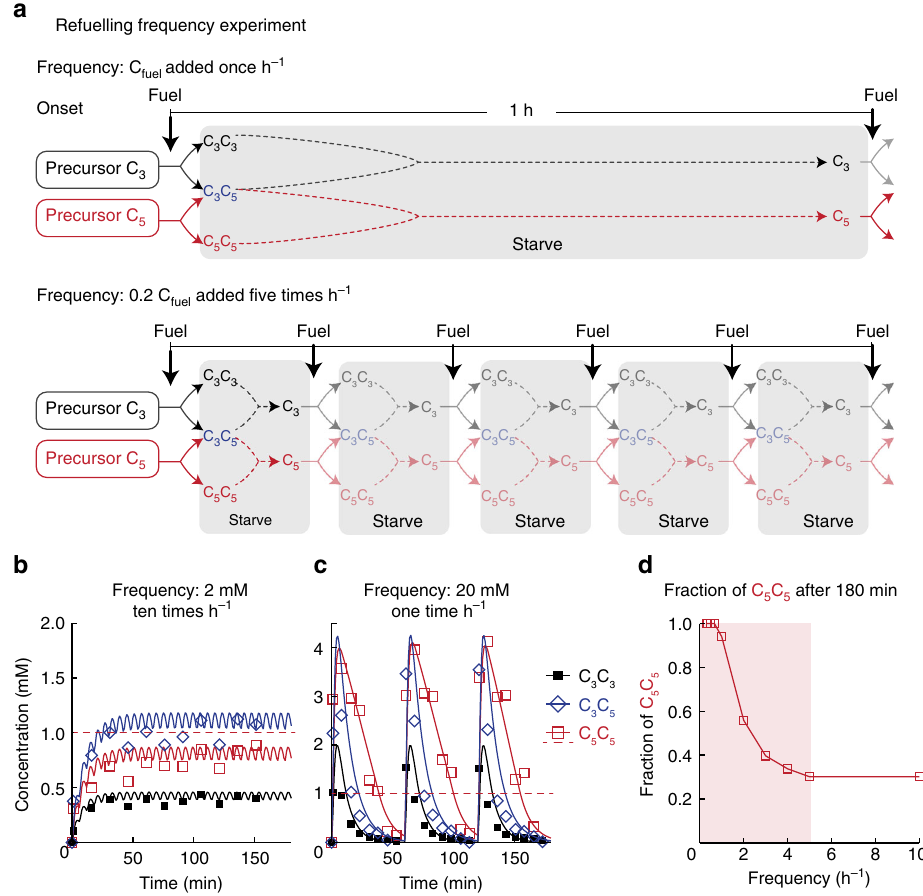
Fig. 3 The method of fueling affects the selection process. a Minimalistic representation of the chemical reaction networks in competition experiments with varying frequency of fueling. Solutions of 300 mM C 3 and 300 mM C 5 are fueled with equal fuel fl ux, but varying frequency. Fuel can be added once per hour (top, 1 h − 1 ) or fi ve times per hour in smaller batches (bottom, 5 h − 1 ). b , c The concentration of anhydride products against time when a mixture of 300 mM C 3 and 300 mM C 5 is fueled 60 mM EDC in a 3h experiment. The fuel was either supplied b with a frequency of 1 × 20 mM h − 1 or c 10 × 2 mM h − 1 . Markers represent HPLC data; solid lines represent calculated data. The red dashed line indicates the solubility of C 5 C 5 . d Plot of the fraction of C 5 C 5 after 3 h against the frequency of fuel addition. Only at a frequency below 5 h − 1 phase-separation occurred (gray-shaded